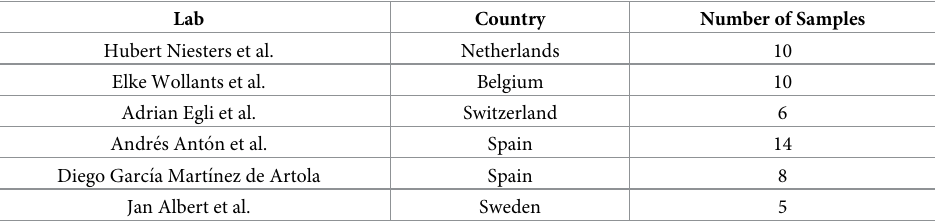
Table 1. 2018 Samples